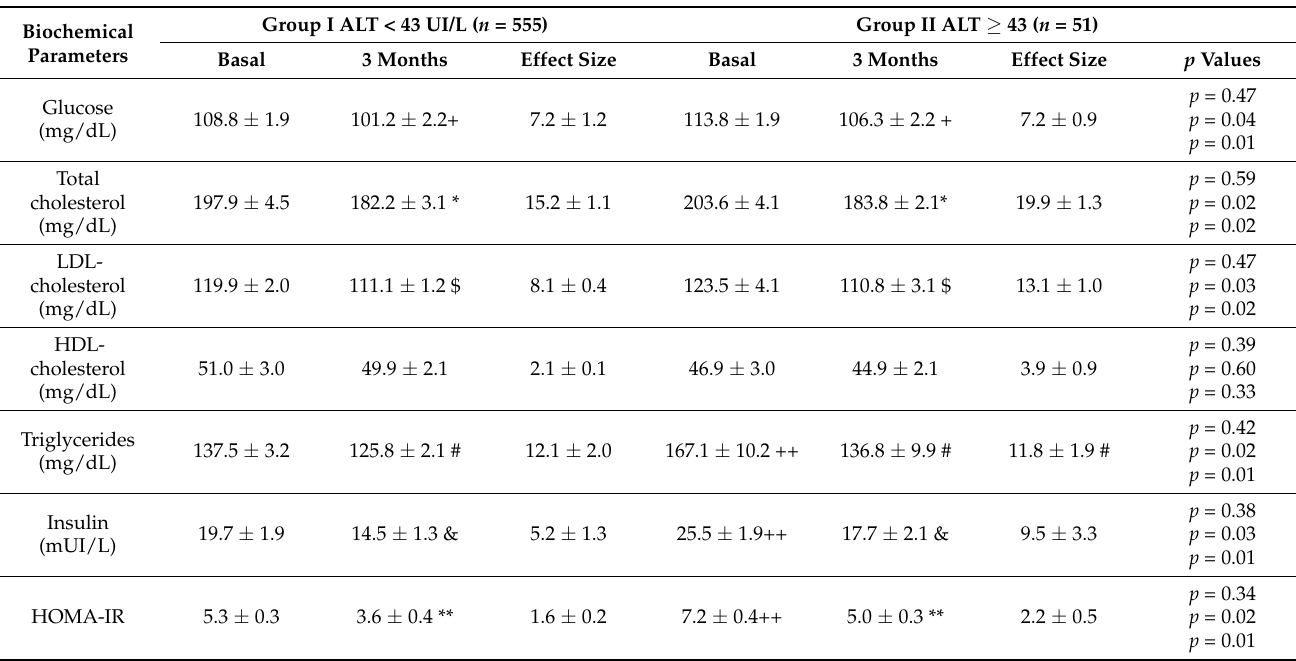
Table 5. Biochemical parameters in different groups (mean ± standard deviation) at basal time and after 3 months of